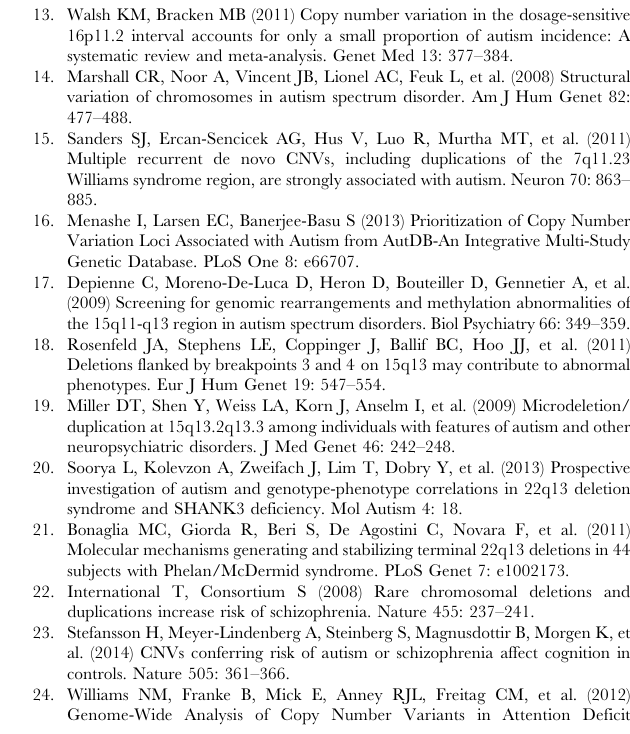
Table S2 Ancestral Contributions in Brazilian ASD- affected individuals.